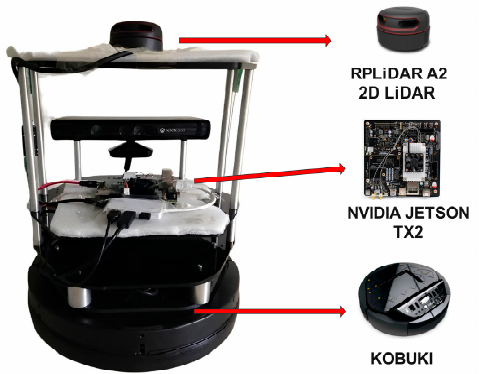
Figure 1. Robotics platform.